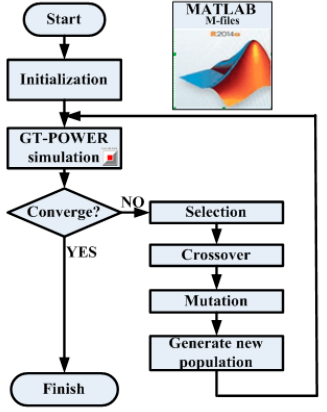
Figure 4. System block diagram.